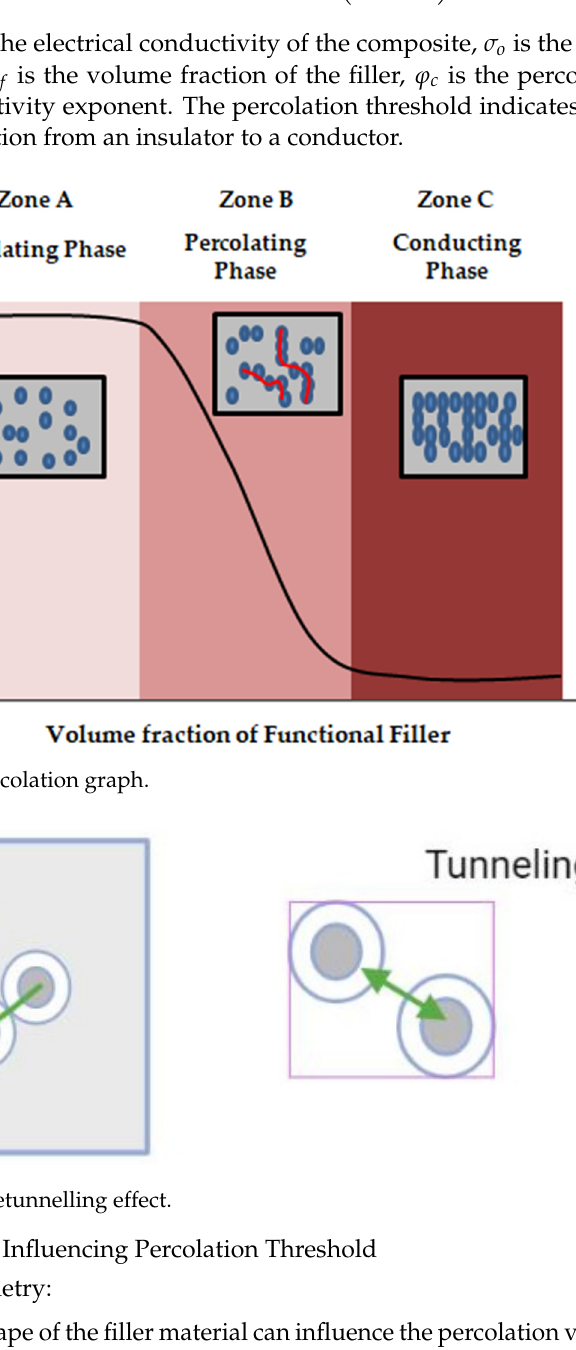
Table 4. Influencing parameters of the percolation threshold.